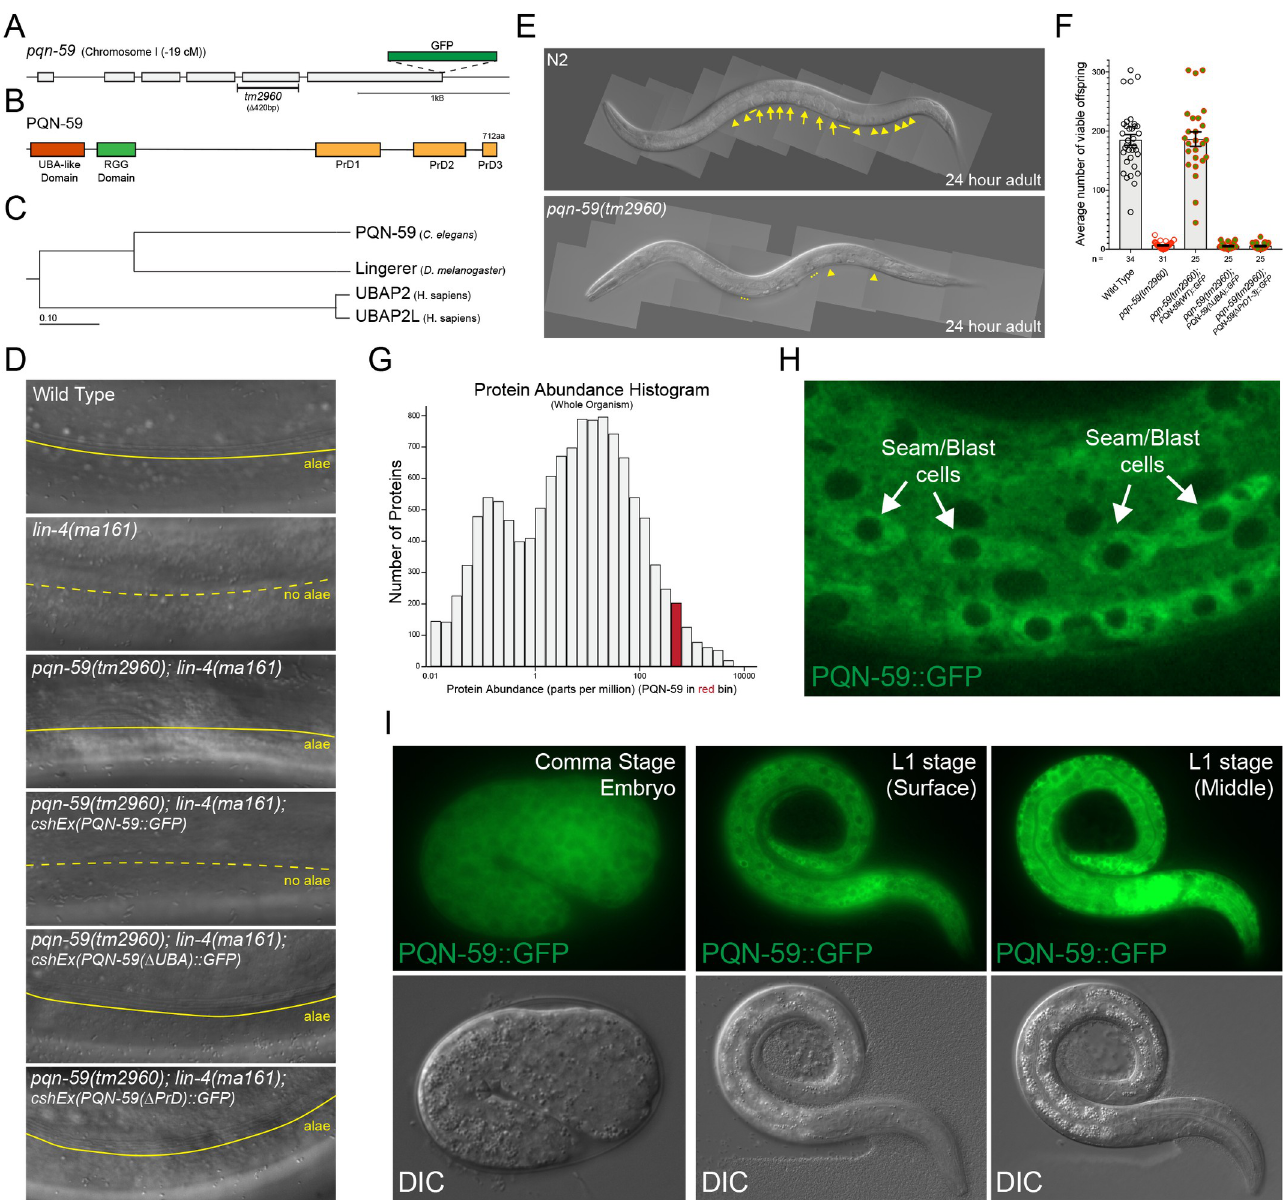
Fig 3. The pqn-59 gene encodes an abundant, ubiquitously-expressed protein that is essential for normal fecundity. (A and B) Diagrams of the pqn-59 gene and protein product. In panel A, the location of the tm2960 deletion and the site of CRISPR-mediated GFP insertion that generates a functionally tagged allele of pqn-59 . Panel B indicates the three discernable protein domains of PQN-59. (C) Evolutionary relationship between PQN-59 and orthologs in other model systems. (D) Micrographs of animal cuticles depicting the presence or absence of adult-specific alae structures. In contrast to the inappropriate absence of adult alae in lin-4(ma161) animals, wild-type and pqn-59(tm2960); lin-4(ma161) animals exhibit these structures. Re-expression of full-length PQN-59::GFP (but not versions of the transgene that lack the UBA or PrDs) in pqn-59(tm2960); lin-4(ma161) animals result in lin-4(ma161) -like, retarded hypodermal development. (E) Images of 24hr, adult wild-type and pqn-59(tm2960) animals demonstrating the differences in fertility. Arrowheads indicate developing oocytes and arrows indicate fertilized embryos. Dashed lines indicate regions of the germline where sperm are present. (F) Graph depicting the range of offspring with wild-type, pqn- 59(tm2960) and pqn-59(tm2960) animals that express a functional, full-length PQN-59::GFP transgene (including upstream and downstream regulatory regions) targeted to chromosome II or variants of this transgene that lack the UBA or the three C-terminal prion-like domains. (G) Proteomic data from Version 4.0 of PaxDb: Protein abundance data indicating that PQN-59 is a very abundant protein. (H) Localization of the endogenously GFP-tagged allele of PQN-59 in lateral seam cells demonstrating that PQN-59 is a cytoplasmically localized. (I) Images of the same PQN-59::GFP transgene demonstrating that PQN-59 is expressed in all cell types throughout embryonic and post-embryonic